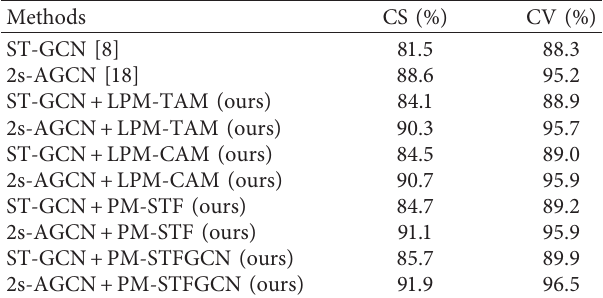
Table 1: Ablation study on the benchmark of NTU-RGB +D.